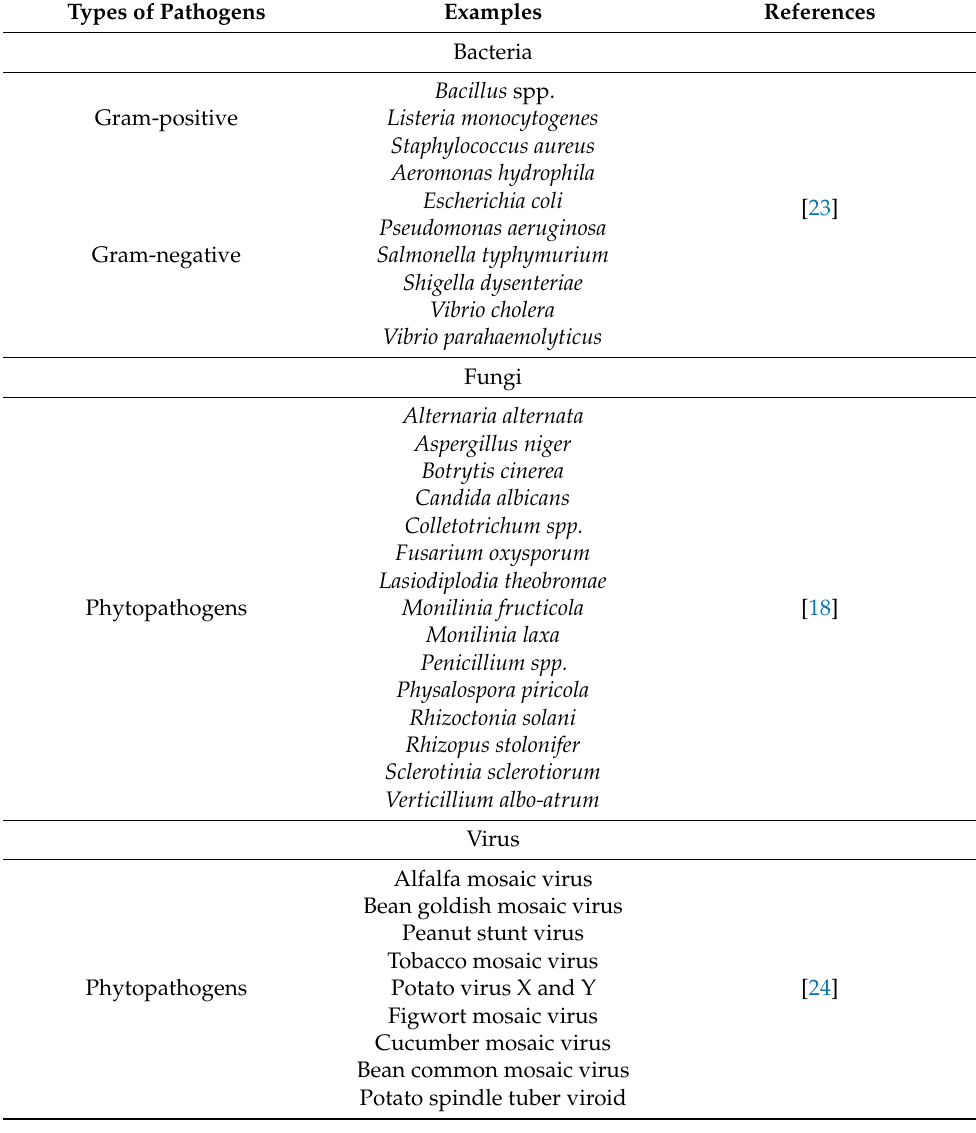
Table 1. Pathogens inhibited by the action of